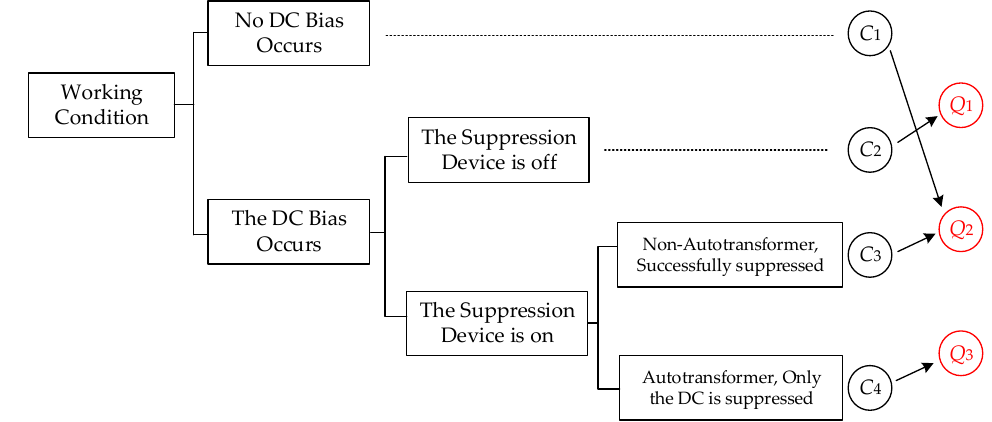
Figure 4. The classification of working conditions.